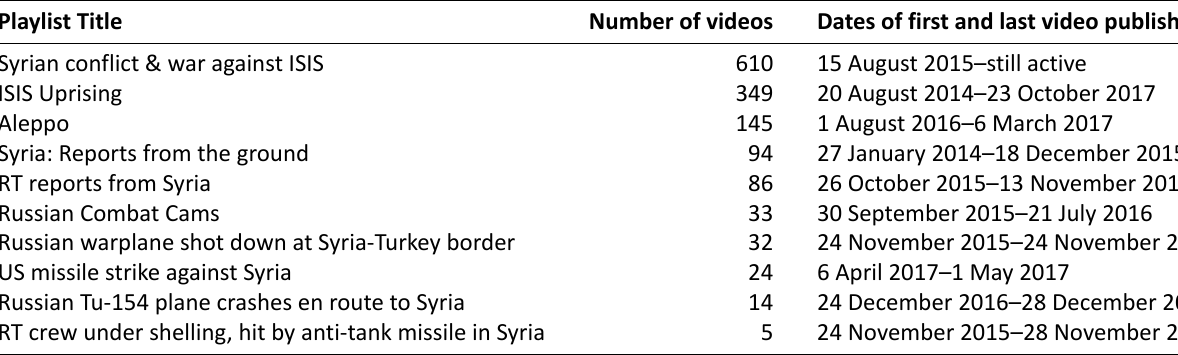
Table 1. RT playlists of videos on the Syrian conflict. Playlist Title Number of videos Dates of first and last video published Syrian conflict & war against ISIS